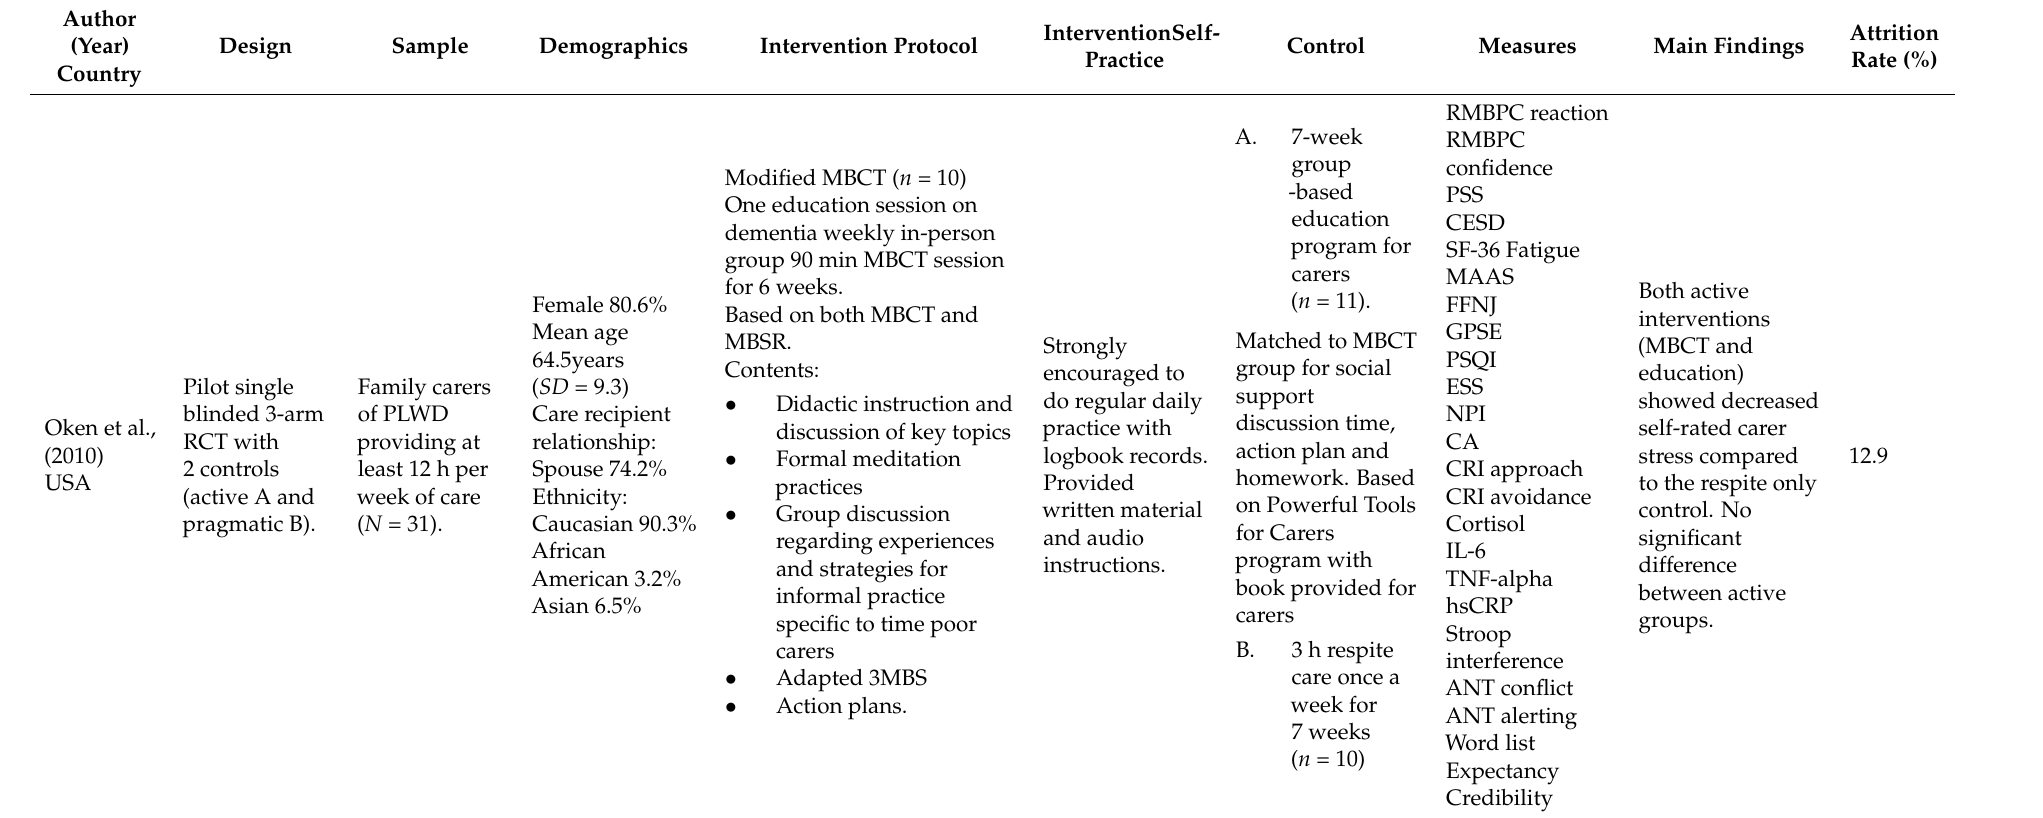
Table 1. Summary of study